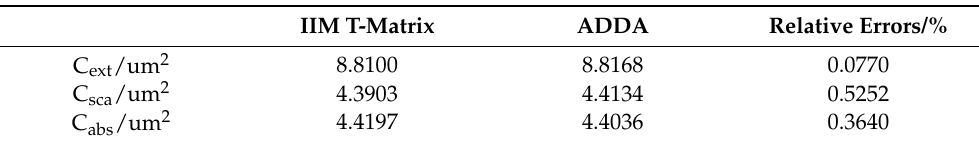
Table 2. The integral scattering properties of the hexagonal prism particles calculated by IIM T-matrix and DDA methods.